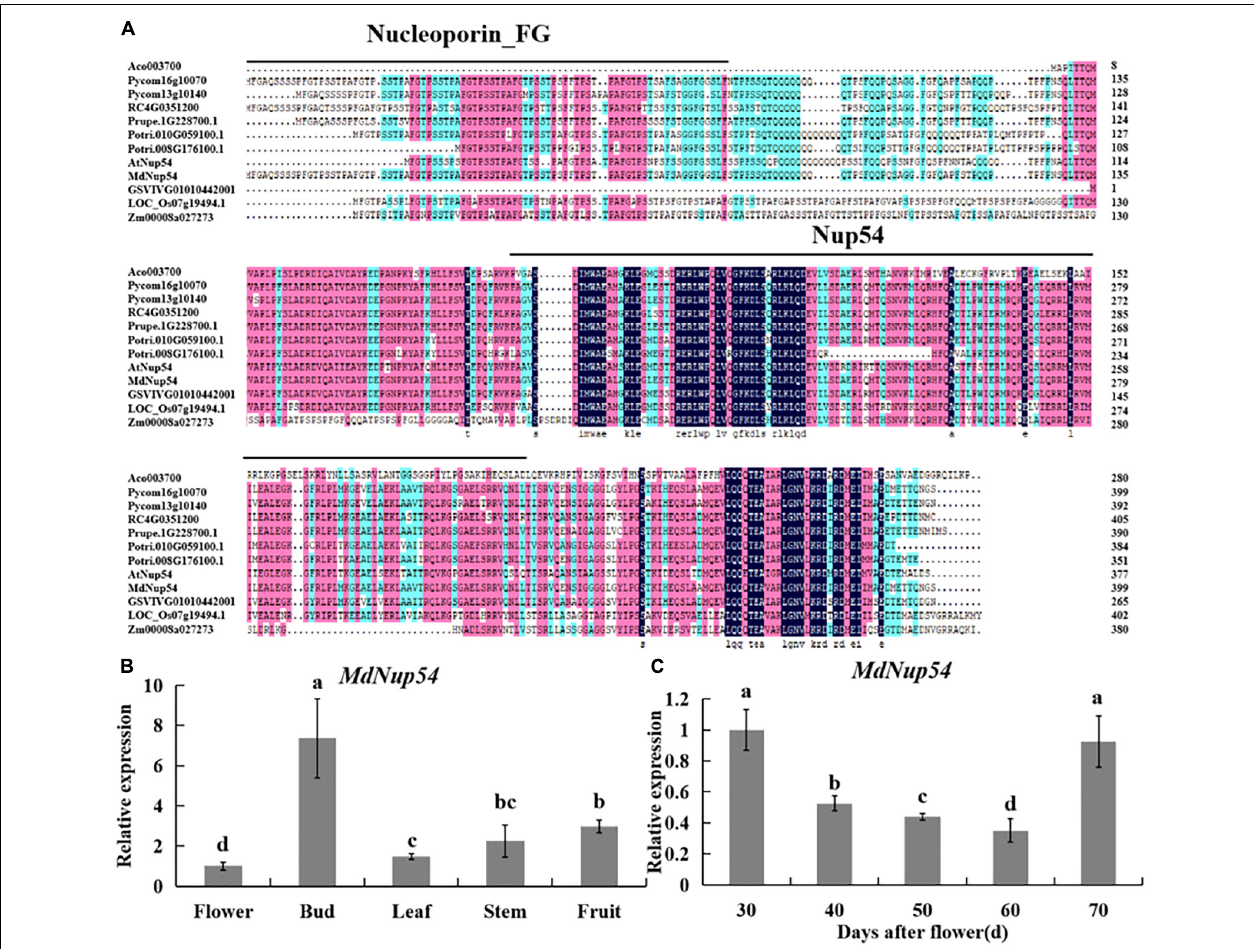
FIGURE 1 | Bioinformatics and expression analysis of MdNup54. (A) The conservative domain of Nup54 in 10 plant species ( Arabidopsis thaliana , Malus domestica , Populus trichocarpa , Oryza sativa , Rosa chinensis , Pyrus communis , Ananas comosus , Vitis vinifera , Zea mays , and Prunus persica ). (B,C) Analyses of MdNup54 expression levels (B) in diverse “Nagafu No. 2” apple tissues and (C) in different flower bud developmental stages of “Nagafu No.